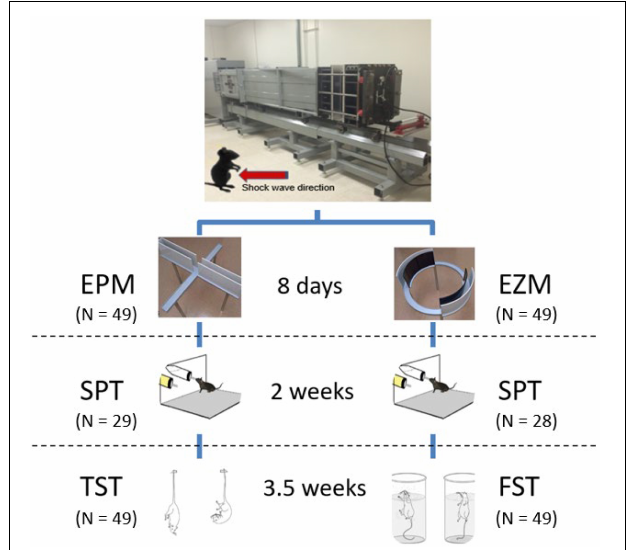
FIGURE 1 | Advanced Blast Simulator and behavioral testing paradigms. A single shock wave ( ∼ 15 psi) was delivered with the mouse in an upright position with the ventral surface of the mouse exposed to the oncoming shock wave (see Vu et al., 2018 for a detailed description of the ABS). Eight days post-injury, animals underwent either EPM or EZM testing followed by the SPT 2 weeks post-injury or sham treatment, and lastly either TST or FST 3.5 weeks following ABS. Images reproduced from Abelaira et al. (2013), with permission from the Brazilian Journal of Psychiatry. Images reproduced from Brigman et al. (2010), Tucker and McCabe